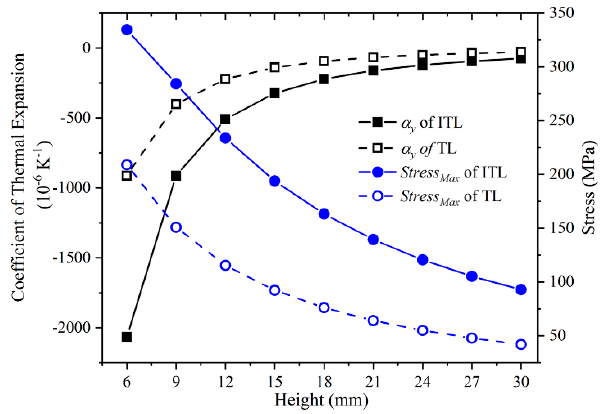
Figure 7. The Y-direction CTE and the maximum stress of the ITL with the varying height and those of the triangular lattice .